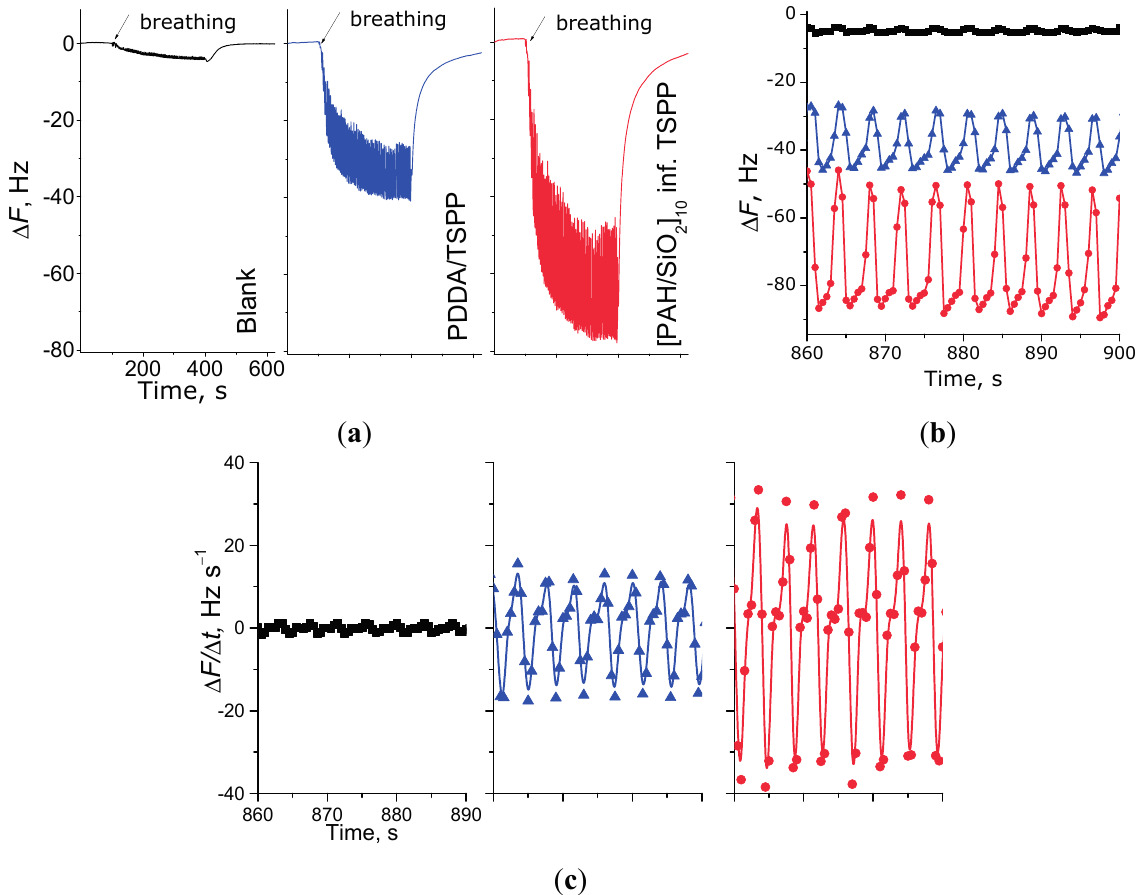
Figure 3. Response of the three different electrodes (blank, coated with PDDA/TSPP (F3) flat film and [PAH/SiO 2 ] 10 inf. TSPP (P3) porous film) to the breathing, demonstrating the influence of the coating. ( a ) General view of frequency shift behavior during the 5 min respiration test; ( b ) magnified view of the frequency oscillation at saturation point; ( c ) first derivative of frequency (speed of frequency change) at saturation